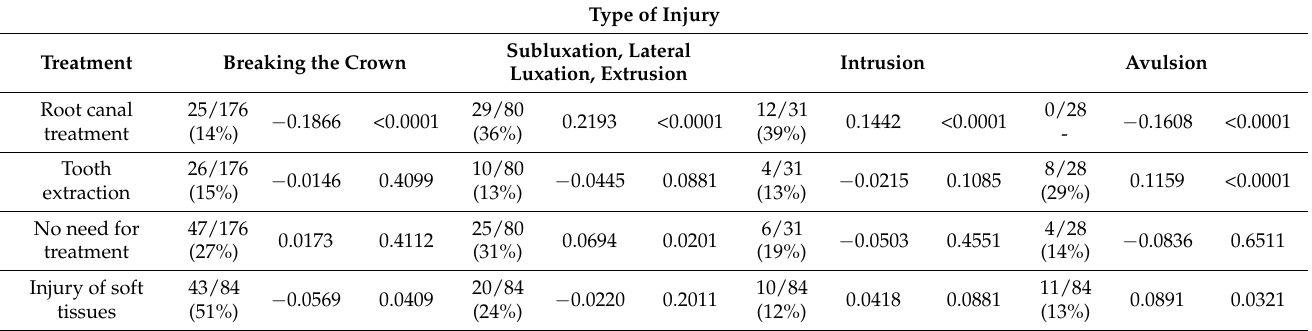
Table 3. Correlations between type of injury and treatment method used (Spearman’s r-correla- tion coefficient).